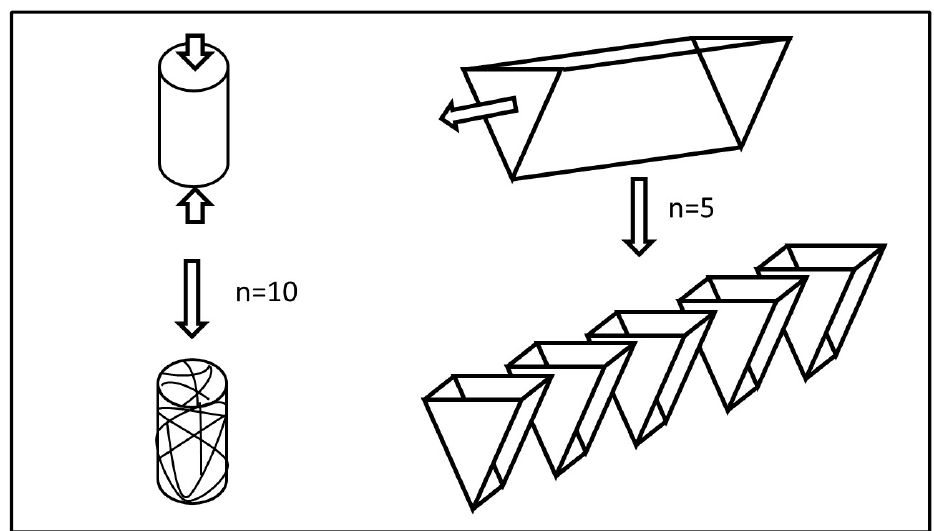
Figure 5. Samples and tests used in this study. Left: Cylinder compression test to failure to measure compressive strength and modulus. Right: Upper: V-shaped block constructed to measure 72 h linear setting expansion along length of block (arrow pointing left). Lower: V-block sectioned to produce five sections for Knoop hardness. Five measurements were recorded on each section and averaged to produce one mean measurement per section.